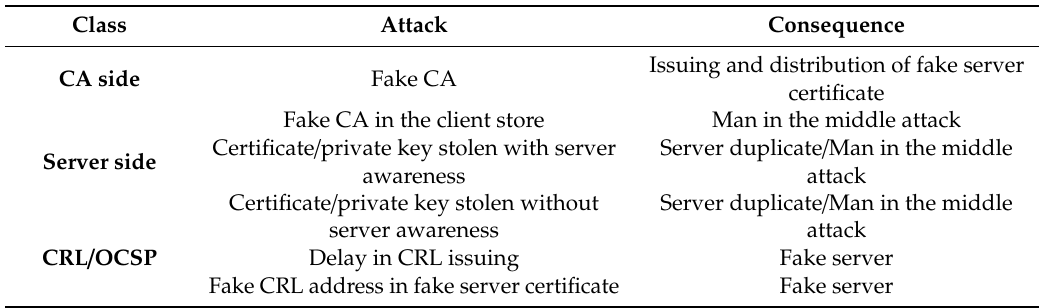
Table 1. Summary of attacks grouped into classes. CA: certificate authority; CRL: certificate revocation